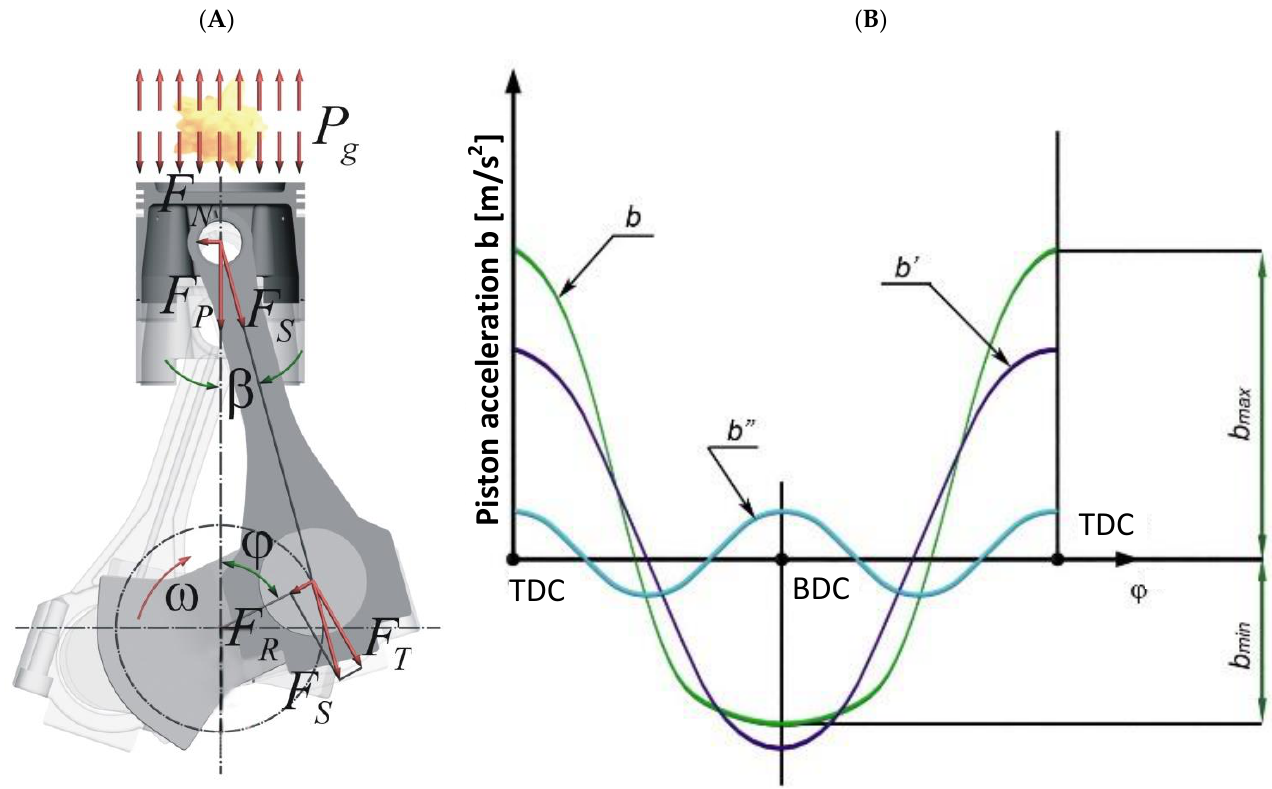
Figure 1. Crankshaft—piston assembly layout ( A ) and changes in acceleration of piston ( B ) as a function of crankshaft position angle φ [7]; b—total acceleration rate of the piston; b’, b”—first and second order accelerations; F N —normal force, F T —force tangential to the circle drawn by the crank throw, F R —radial force acting along the momentary position of the crank arm, F S —resultant force, P g —combustion gas pressure, β —inclination angle of the resultant force, φ—crankshaft position angle, ω —crankshaft angular velocity, TDC, BDC—top and bottom return positions of the piston.